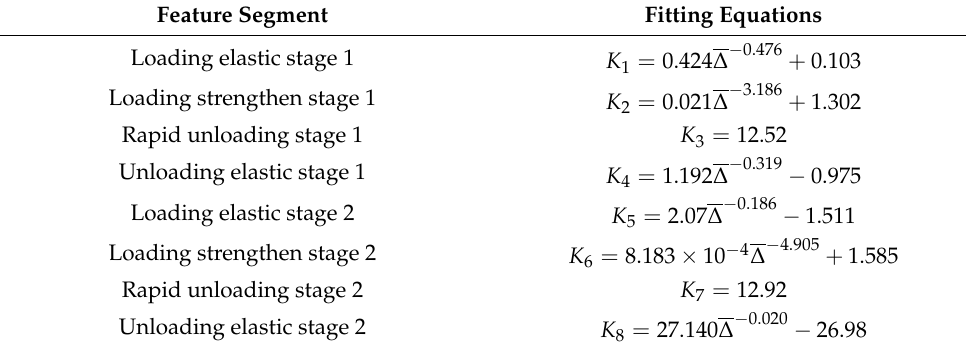
Table 7. Fitting equations of the stiffness.